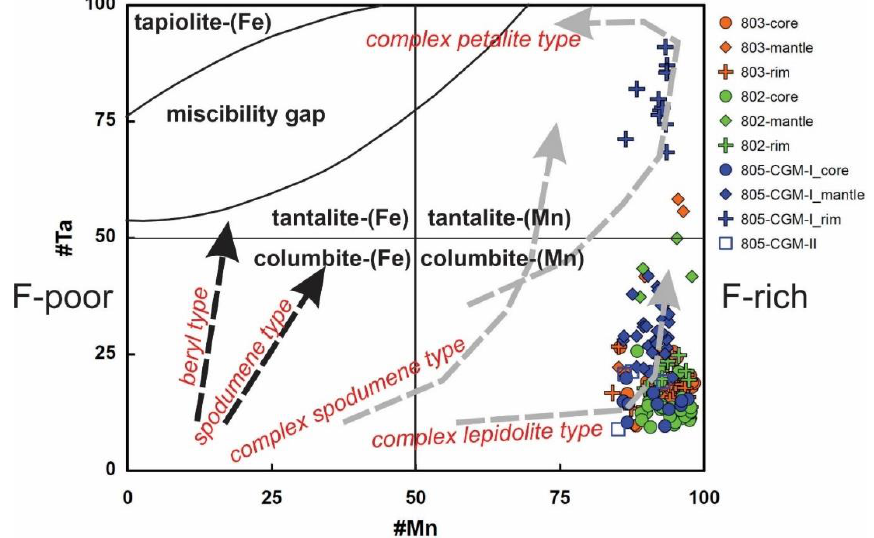
Figure 6. #Ta-#Mn quadrilateral diagram [41] for CGMs from the Li pegmatites at Kalu’an . The Ta and Mn enrichment trends for CGMs in fluorine-rich and fluorine-poor pegmatites are also based on [41]. Pegmatites of beryl and spodumene types are commonly F-poor whereas pegmatites of complex types are